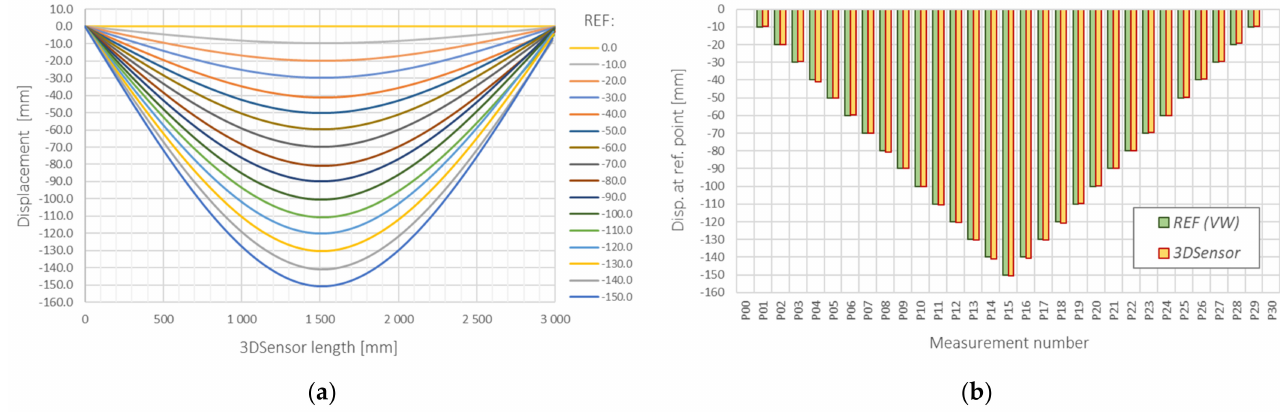
Figure 18. 3DSensor in the scheme of simply supported beam: ( a ) calculated vertical displacements; ( b ) comparison between calculated midspan displacements with a reference vibrating wire